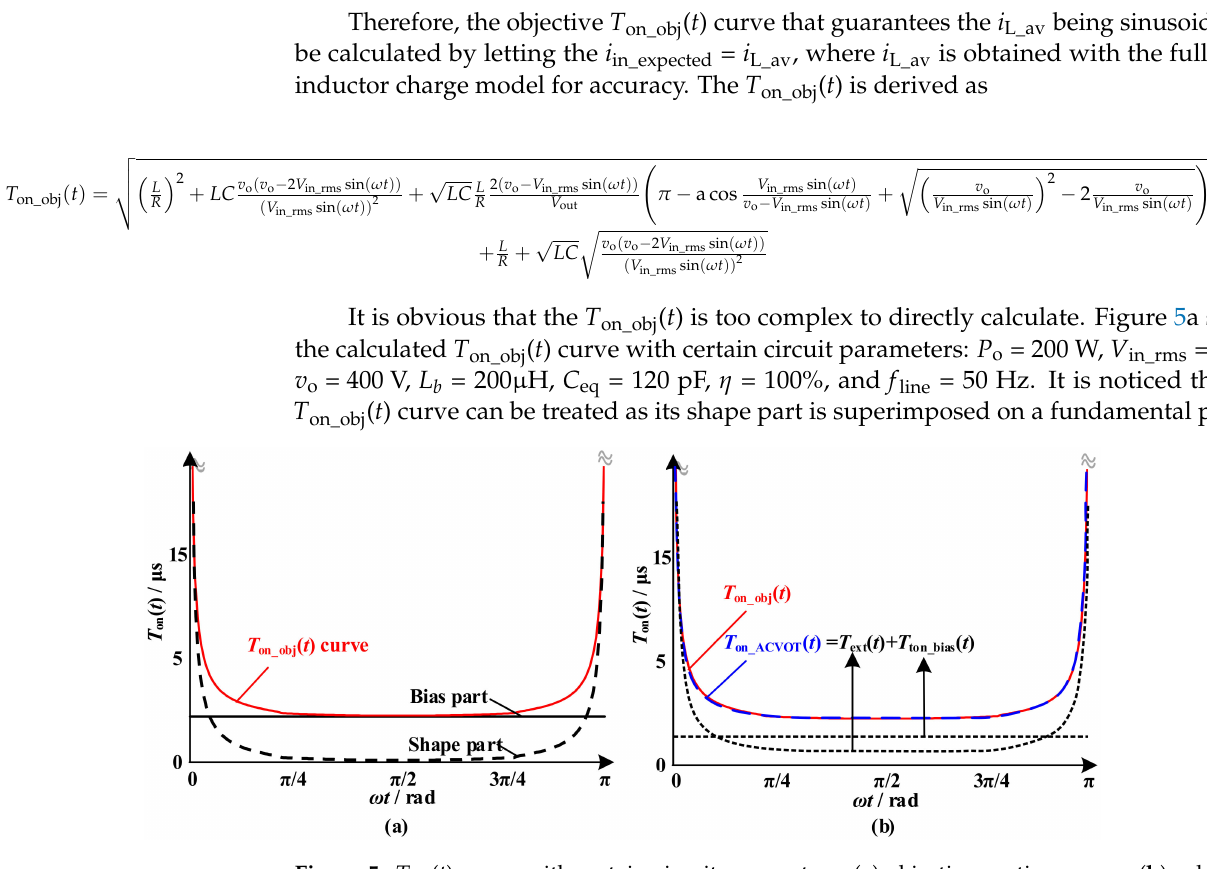
Figure 5. T on ( t ) curve with certain circuit parameters: ( a ) objective on-time curve, ( b ) calculated on-time curve under ACVOT